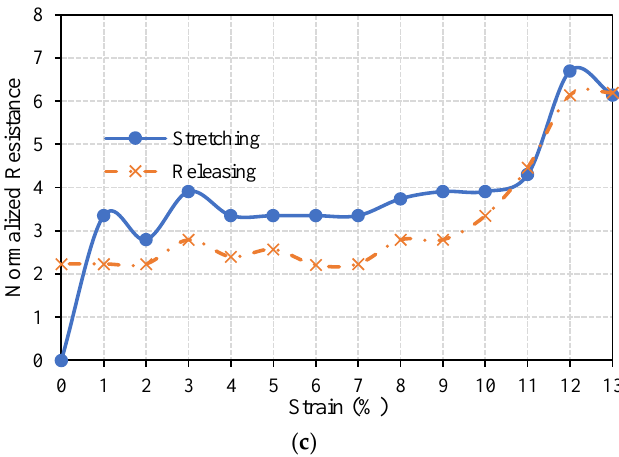
Figure 13. The change in the normalized resistance of the horseshoe pattern with: ( a ) one layer and a linewidth of 1.5 mm; ( b ) one layer and a linewidth of 2 mm; and ( c ) two layers and a linewidth of 1.5 mm, printed on the optimal radially pre-stretched samples under radial load.